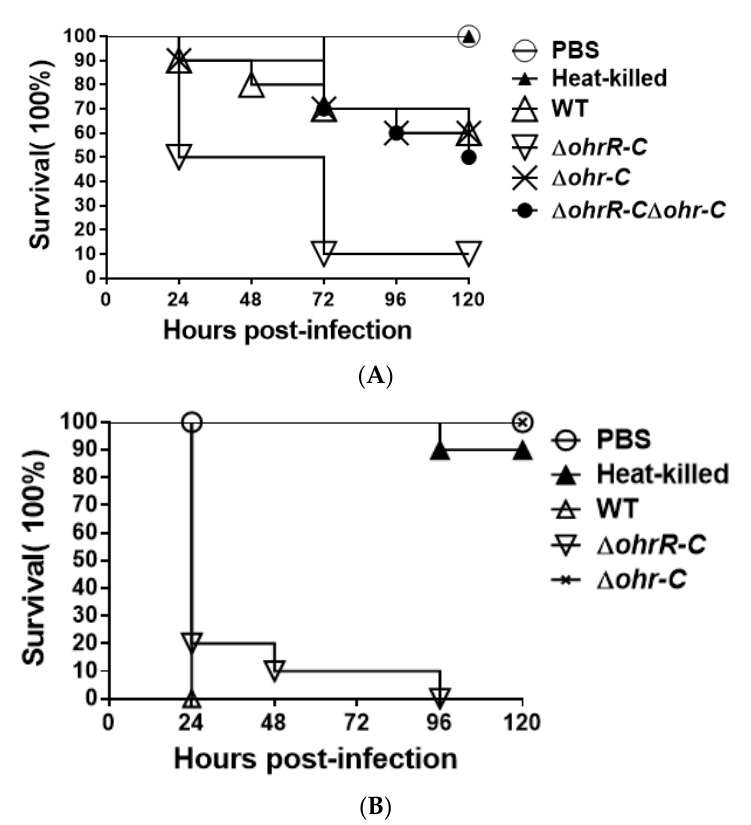
Figure 10. G. mellonella survival curve following infection with A. baumannii wild-type and mutants. Larvae were infected with 5 × 10 6 CFU of wild-type or mutant ( A ) ATCC 19606 or ( B ) ATCC 17978 strains. PBS was used as the buffer. Heat-killed indicates wild-type bacteria treated at 100 °C for 10 min. WT, wild type bacteria; Δ ohrR-C , ohrR-C mutant; Δ ohr-C , ohr-C mutant; Δ ohrR-C Δ ohr-C , ohrR-C-ohr-C double mutant. The curve represents a single experiment performed with 10 larvae.